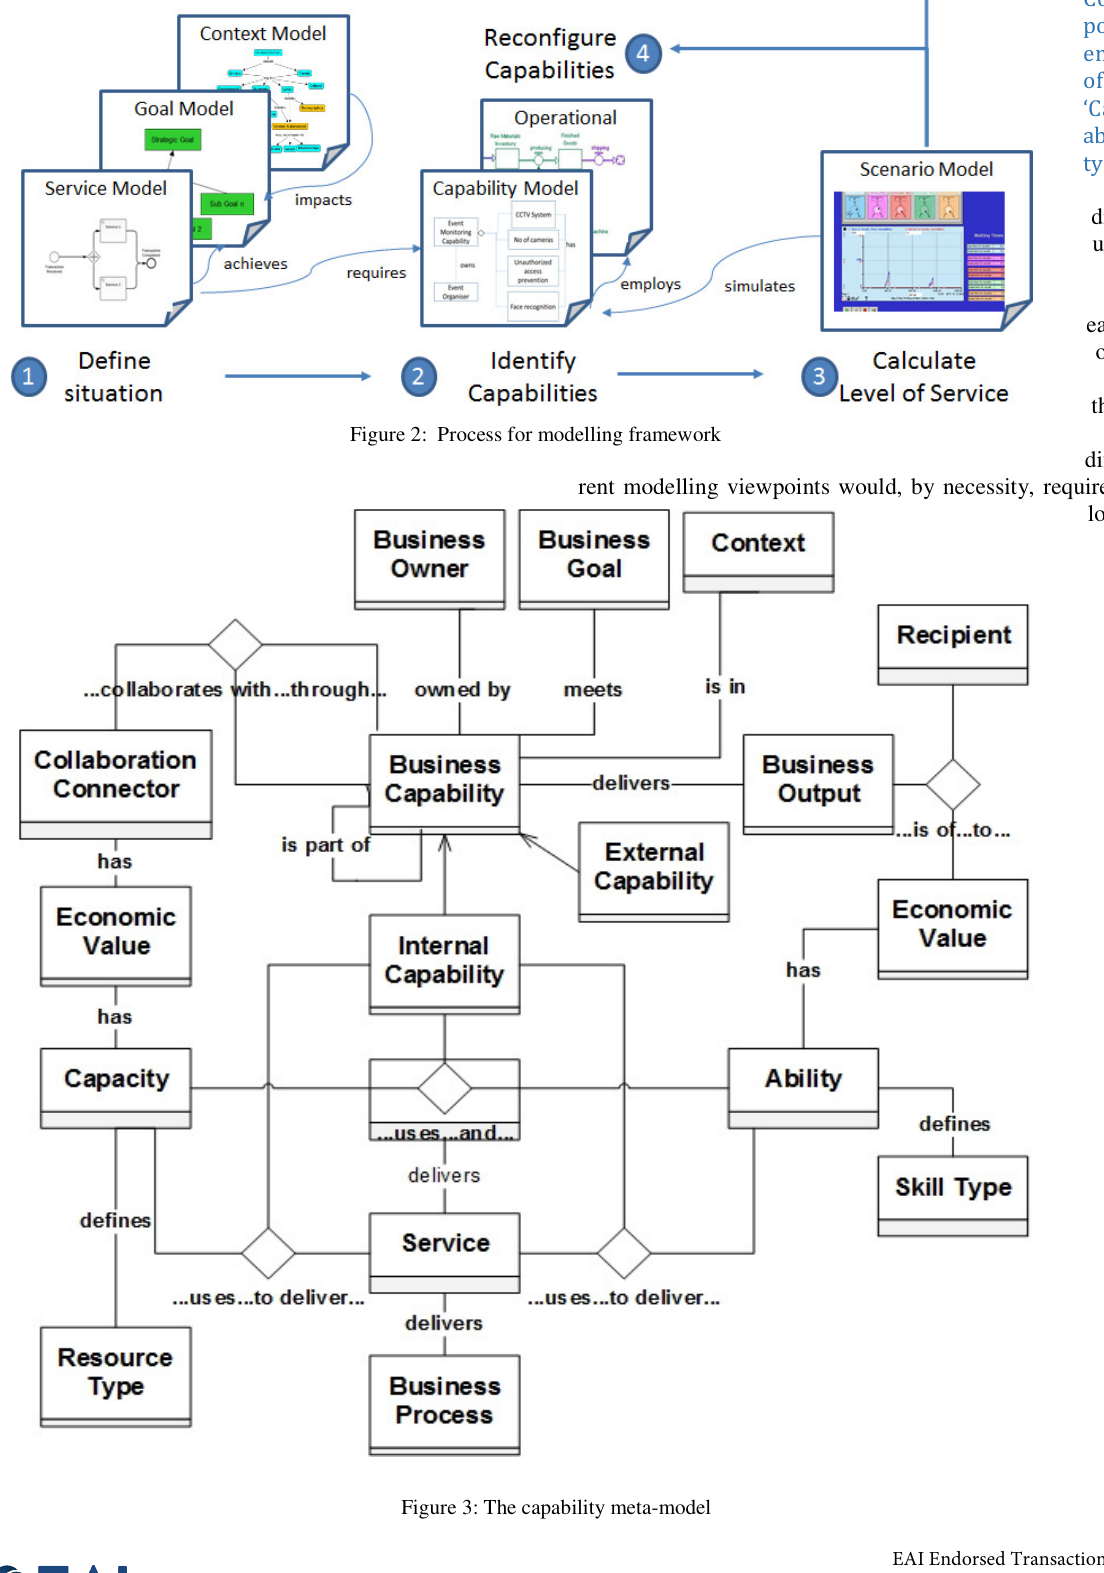
Figure 3: The capability